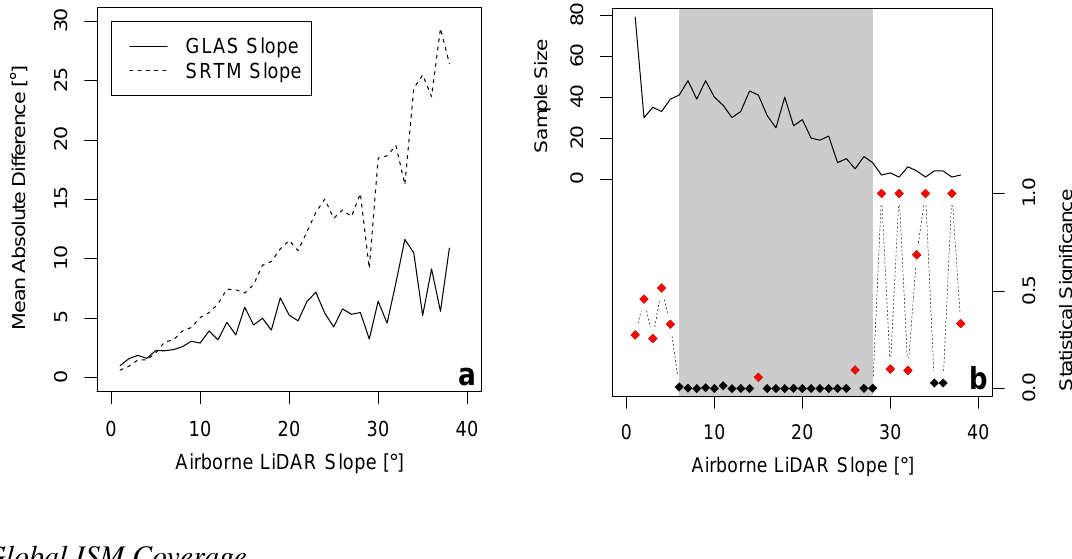
Figure 7. ( a ) Mean absolute difference between ALS slope observations and ISM and SRTM equivalent measurements per 1 ◦ slope interval for seven sites, subject to SRTM data availability. ( b ) Sample size (left axis) and statistically ( p -value) significant difference between SRTM and ISM slope data (right axis), per 1 ◦ slope interval. Note, black points within the grey area are statistically significant at 95% confidence ( p ≤ 0 . 05 ), whereas red points are